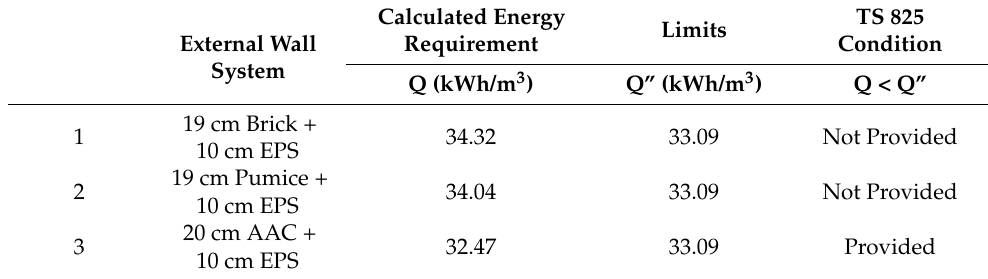
Table 8. The 4th climate zone.